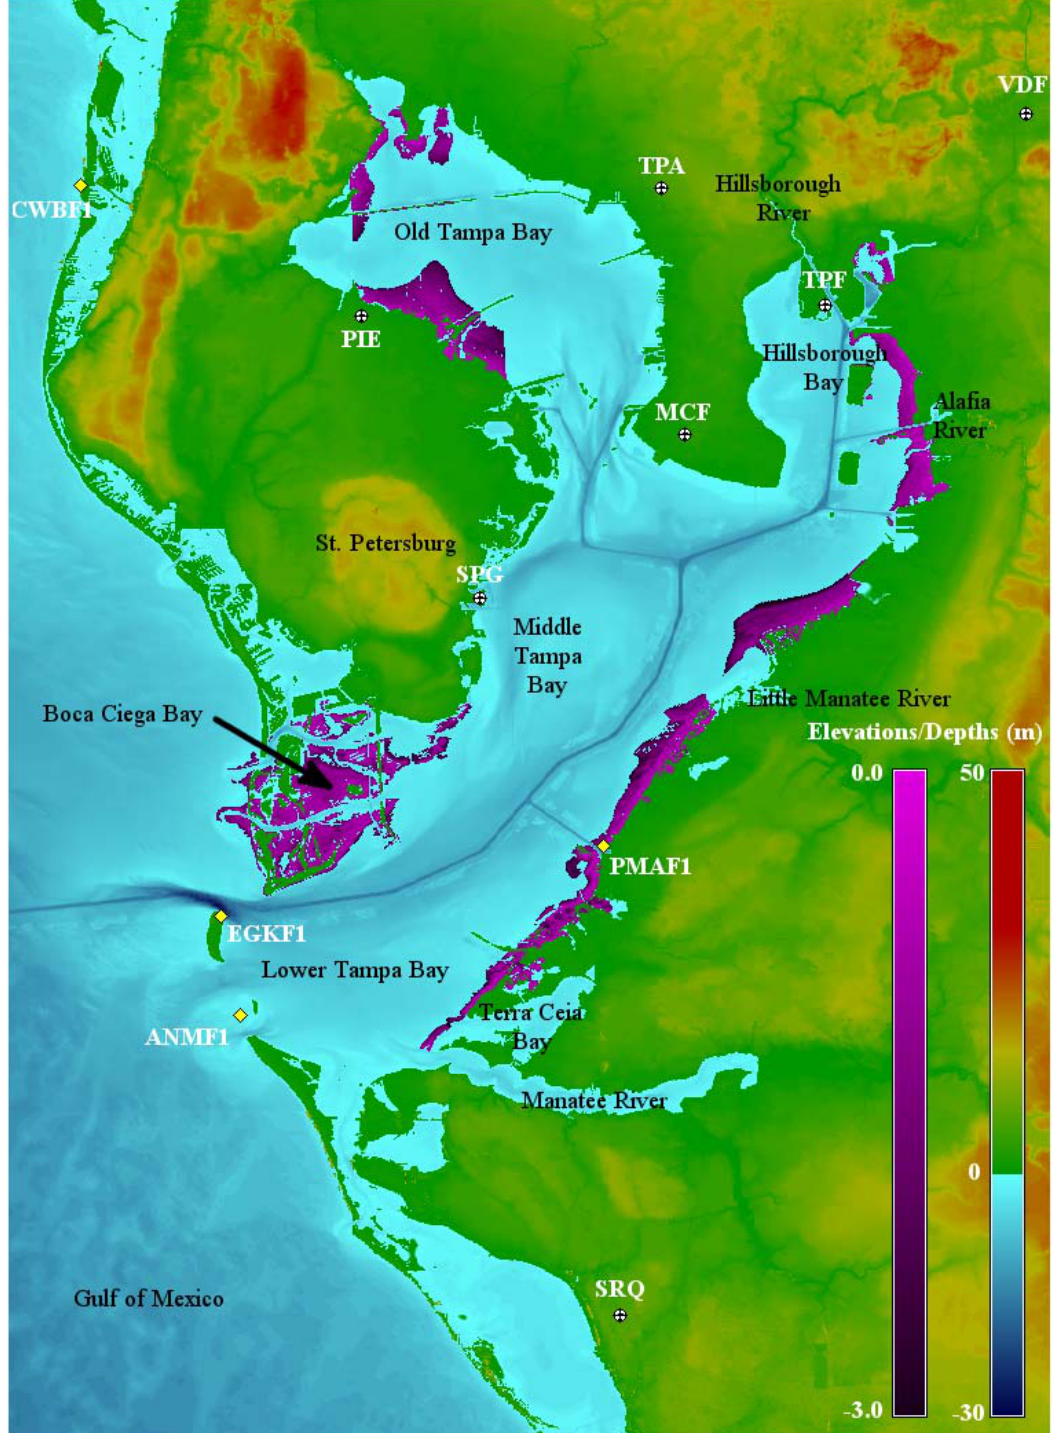
Figure 7. Topobathymetry of Tampa Bay. Bathymetry in purple is derived from an airborne lidar survey in May 2007 [38]; topography and bathymetry in blue is a composite of NOAA GEODAS and the Global Multi-Resolution Topography product [39]. Also shown are the seven airports and four CMAN buoys from which wind speed and/or visibility data were obtained. The map is shown in a latitude-longitude pseudoprojection, with northwest corner [28°04 ′ 26.546304 ″ N, 82°52 ′ 08.082264 ″ W], and southeast corner [27°19 ′ 58.28718 ″ N, 82°19 ′ 58.004148 ″